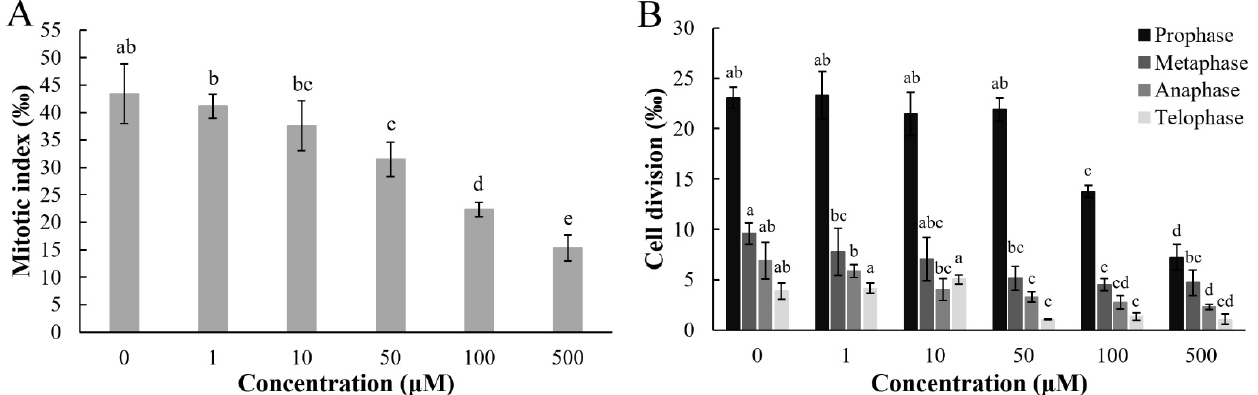
Figure 3. The mitotic index ( A ) and mitosis process ( B ) in root tip cells of lettuce seedlings after treatments with acacetin. The results presented are the mean of three replicates ± SE, different letters denote significant differences at p < 0.05 according to one-way ANOVA with an LSD test.